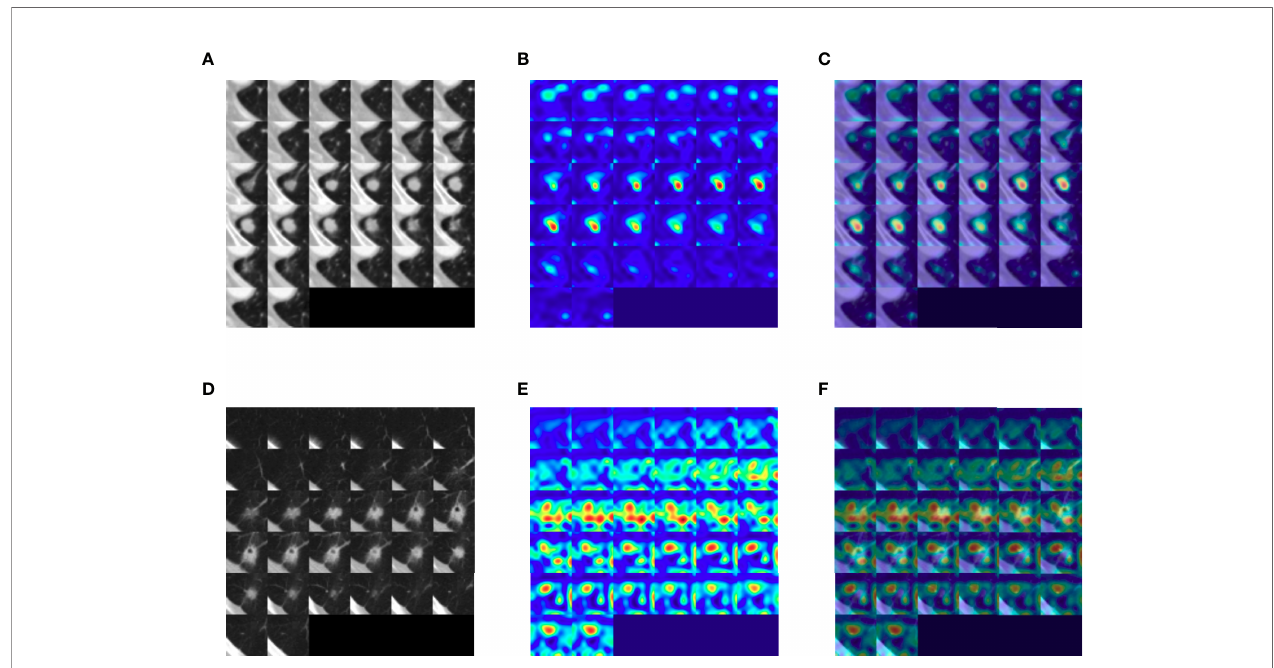
FIGURE 5 | Gradient-weighted class activation heatmaps of nodule cubes. (A) Raw intensity, (B) gradient heatmap, and (C) overaly heatmap of a solid tumor with C/T ratio 1.0 show the area most responsible for the prediction of LVI or nodal involvement to be the solid tumor itself, rather than pleural tag. (D) Raw intensity, (E) gradient heatmap and (F) overlay heatmap of a part-solid tumor with C/T ratio 0.75 show that the area most responsible for the prediction of LVI or nodal involvement to be the interface of the tumor with the adjacent lung